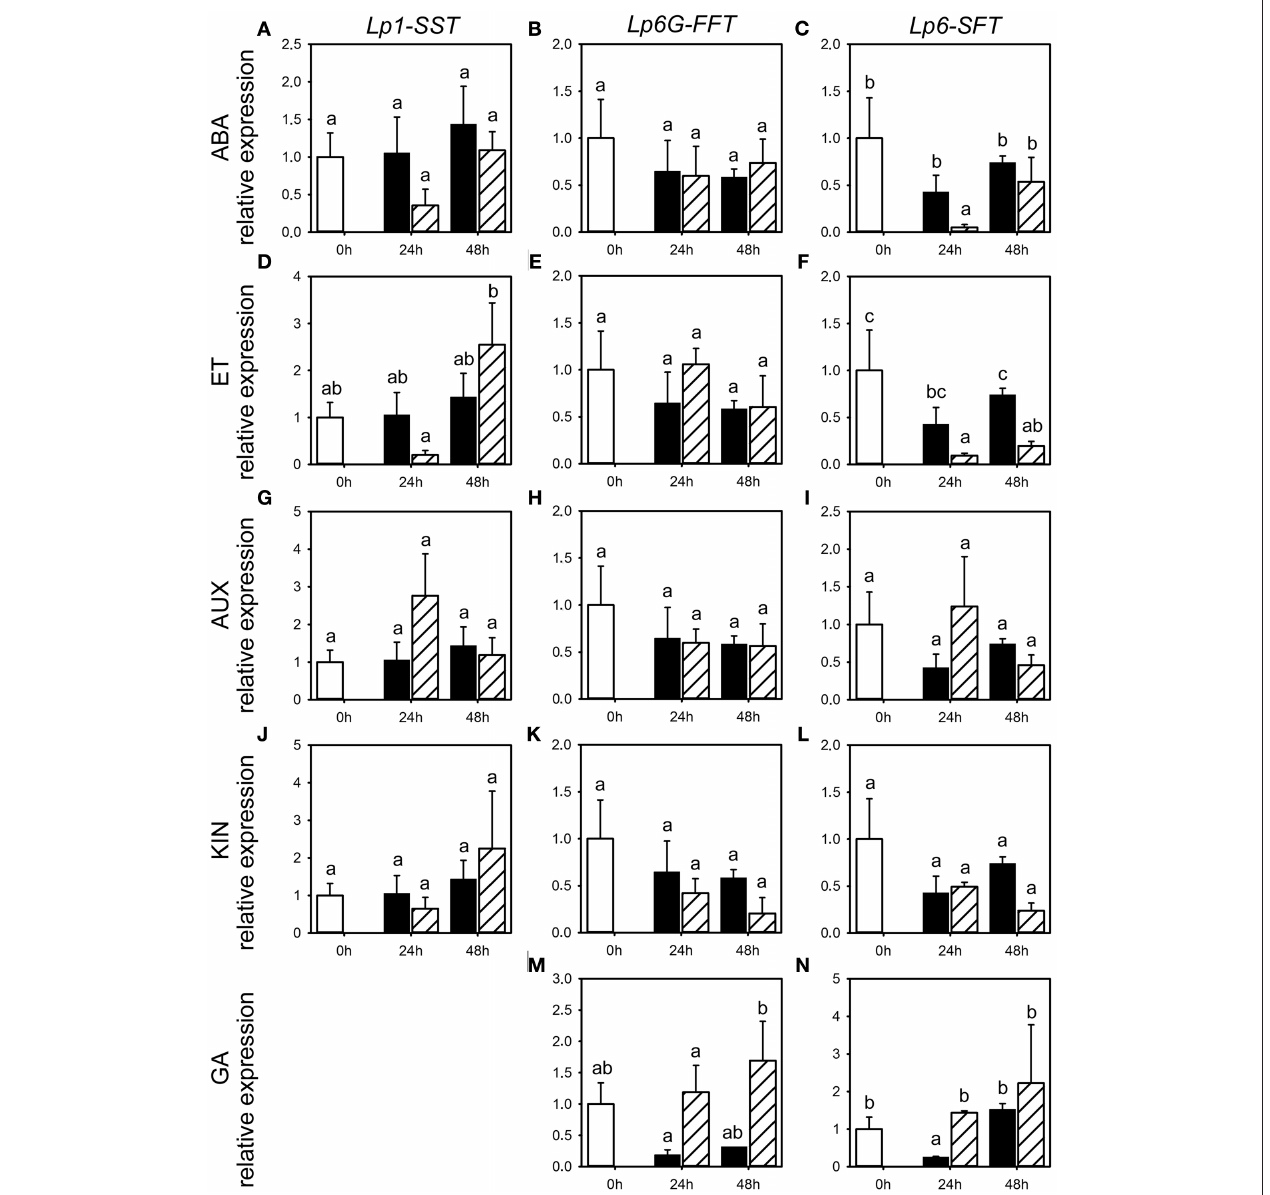
FIGURE 5 | Expression of FTs following phytohormone treatments. Quantitative RT-PCR analysis of Lp1-SST , Lp6G-FFT, and Lp6-SFT expression in stubble of 4-week old perennial ryegrass seedlings 24 or 48h post ABA (A–C) , ET (D–F) , AUX (G–I) , KIN (J–L), or GA (M,N) treatment. Open bars, untreated controls; closed bars, mock treatment; dashed bars, phytohormone treatment. Transcript levels were normalized to untreated controls (expression at 0h). Values represent the mean of three biological replicates ± SE. Different letters indicate statistical significance at p < 0.05